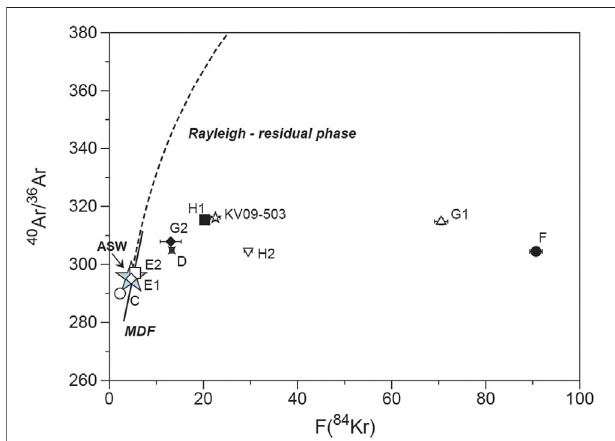
FIGURE 6 | The F( 84 Kr) versus 40 Ar/ 36 Ar ratio measured in the different gypsum layers. The blue star indicates the composition of Air Saturated Water ( 40 Ar/ 36 Ar (cid:1) 295.5 and F( 84 Kr) ranging between 1.835 at 20 ° C and 1.47 at 100 ° C — Smith and Kennedy 1983). The straight line labeled “ MDF ” represents the closed-system isotopic and elemental fractionation of Kr and Ar for a single step mass-dependent fractionation by diffusion. The dashed curve represents a diffusion-controlled Rayleigh